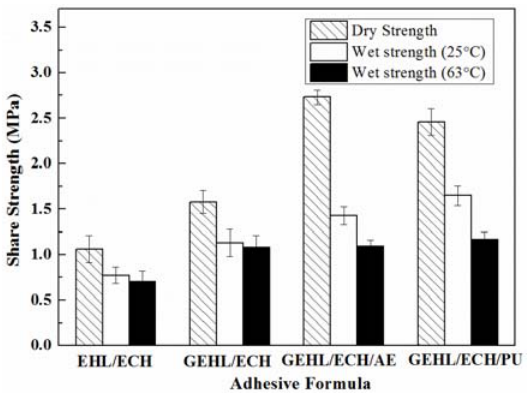
Figure 7. Shear strength and water resistance of lignin-based adhesives: EHL:ECH = 100:30 ( w / w ); GEHL:ECH = 100:30 ( w / w ); GEHL:ECH:AE = 100:20:15 ( w / w / w ); GEHL:ECH:PU = 100:20:15 ( w / w / w ).